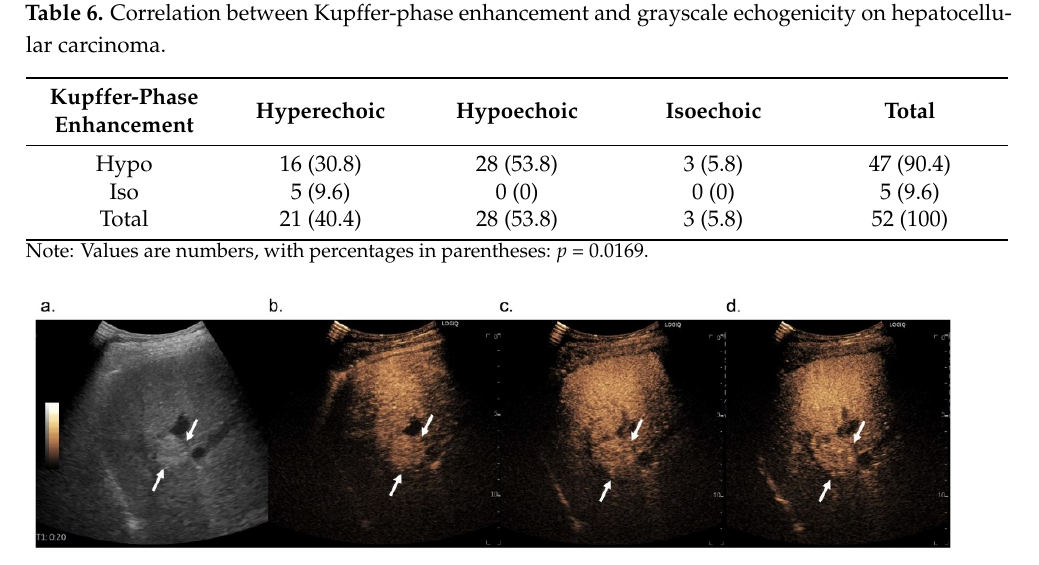
Figure 5. Images in 81-year-old man with pathologically confirmed hepatocellular carcinoma in segment 8 of the liver. In B-mode US, a 2.8 cm hyperechoic nodule is observed ( a , arrows). In Sonazoid- enhanced US, the nodule shows arterial phase hyperenhancement ( b , arrows) and does not show washout until 5 min after contrast media injection ( c , arrows). The nodule shows isoenhancement in the Kupffer phase ( d , arrows).